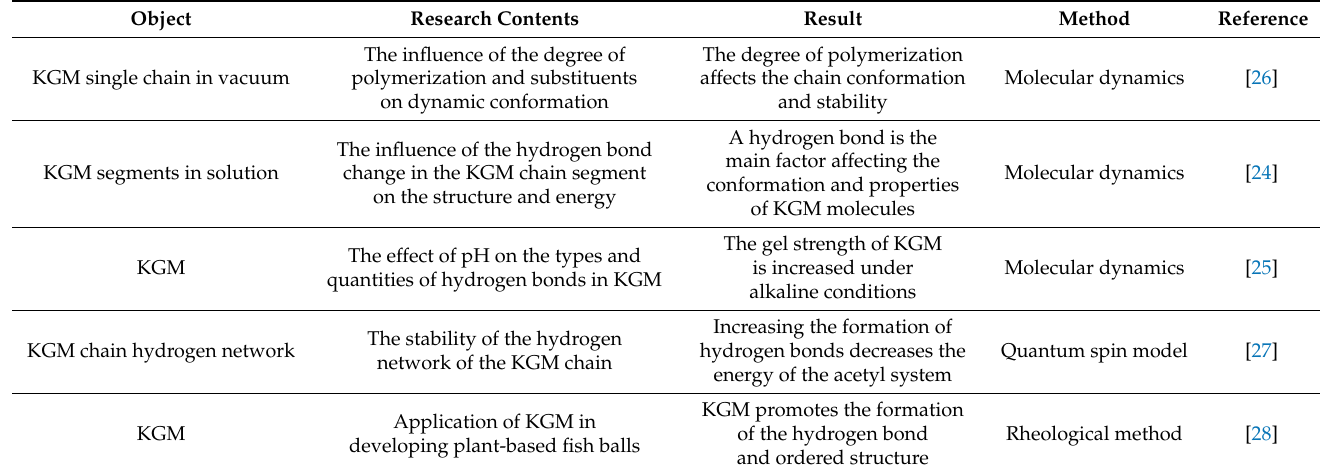
Table 1. The research progress of the KGM hydrogen bond network